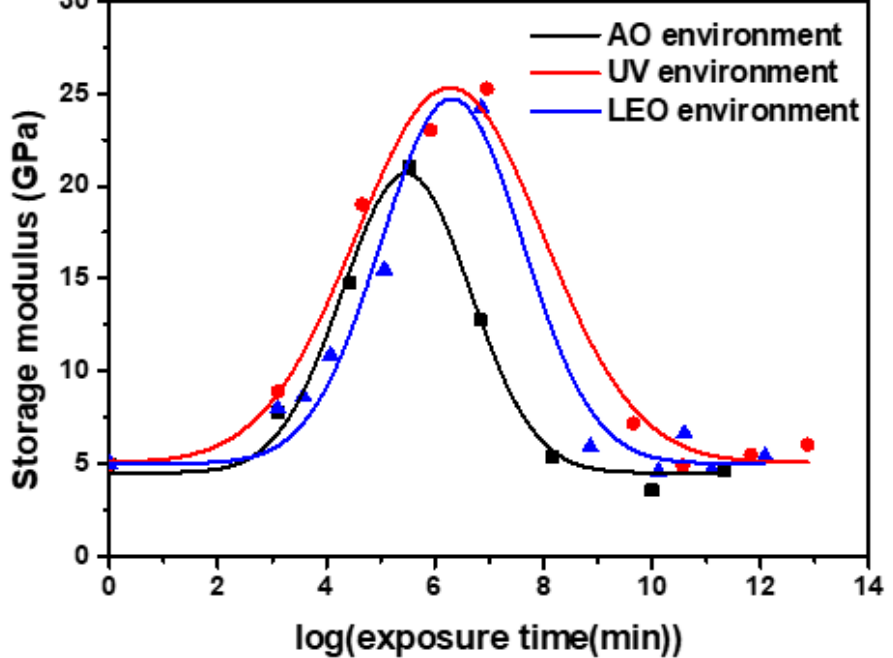
Figure 9. Master curve for each environment (UV, AO and LEO exposure). Each data point represents an experimental value.